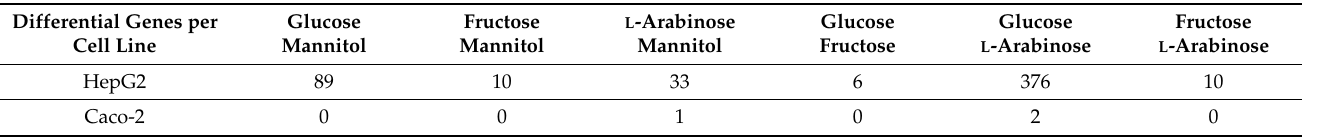
Table 1. Number of genes and KEGG pathways that are altered by the different sugars. Differential genes between exposures.